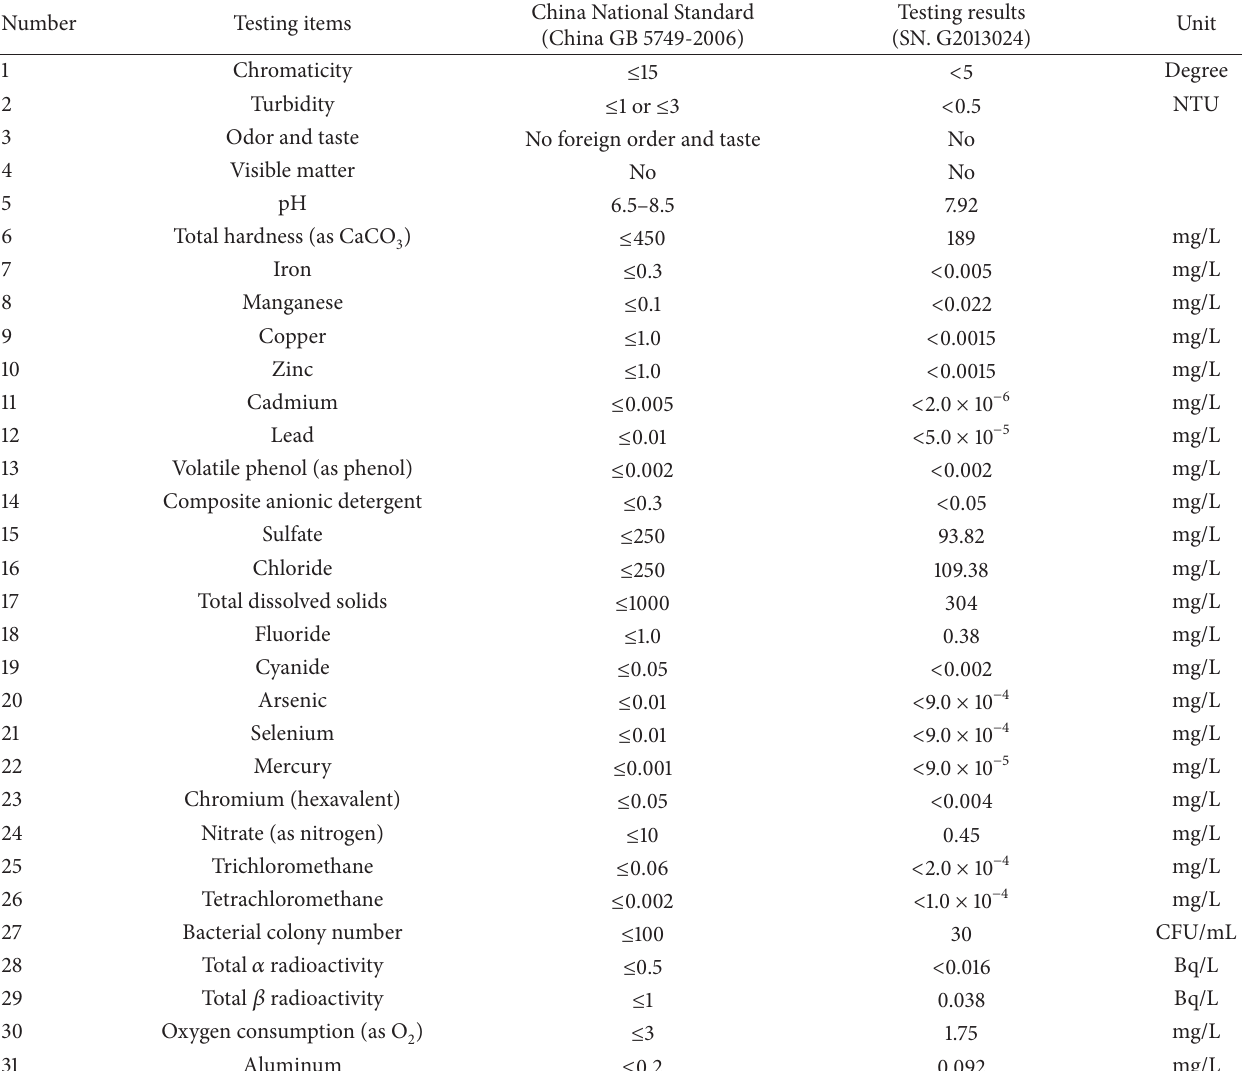
Table 7: The treatment effect for Xinjiang Karamay City drinking water with enhanced flocculant